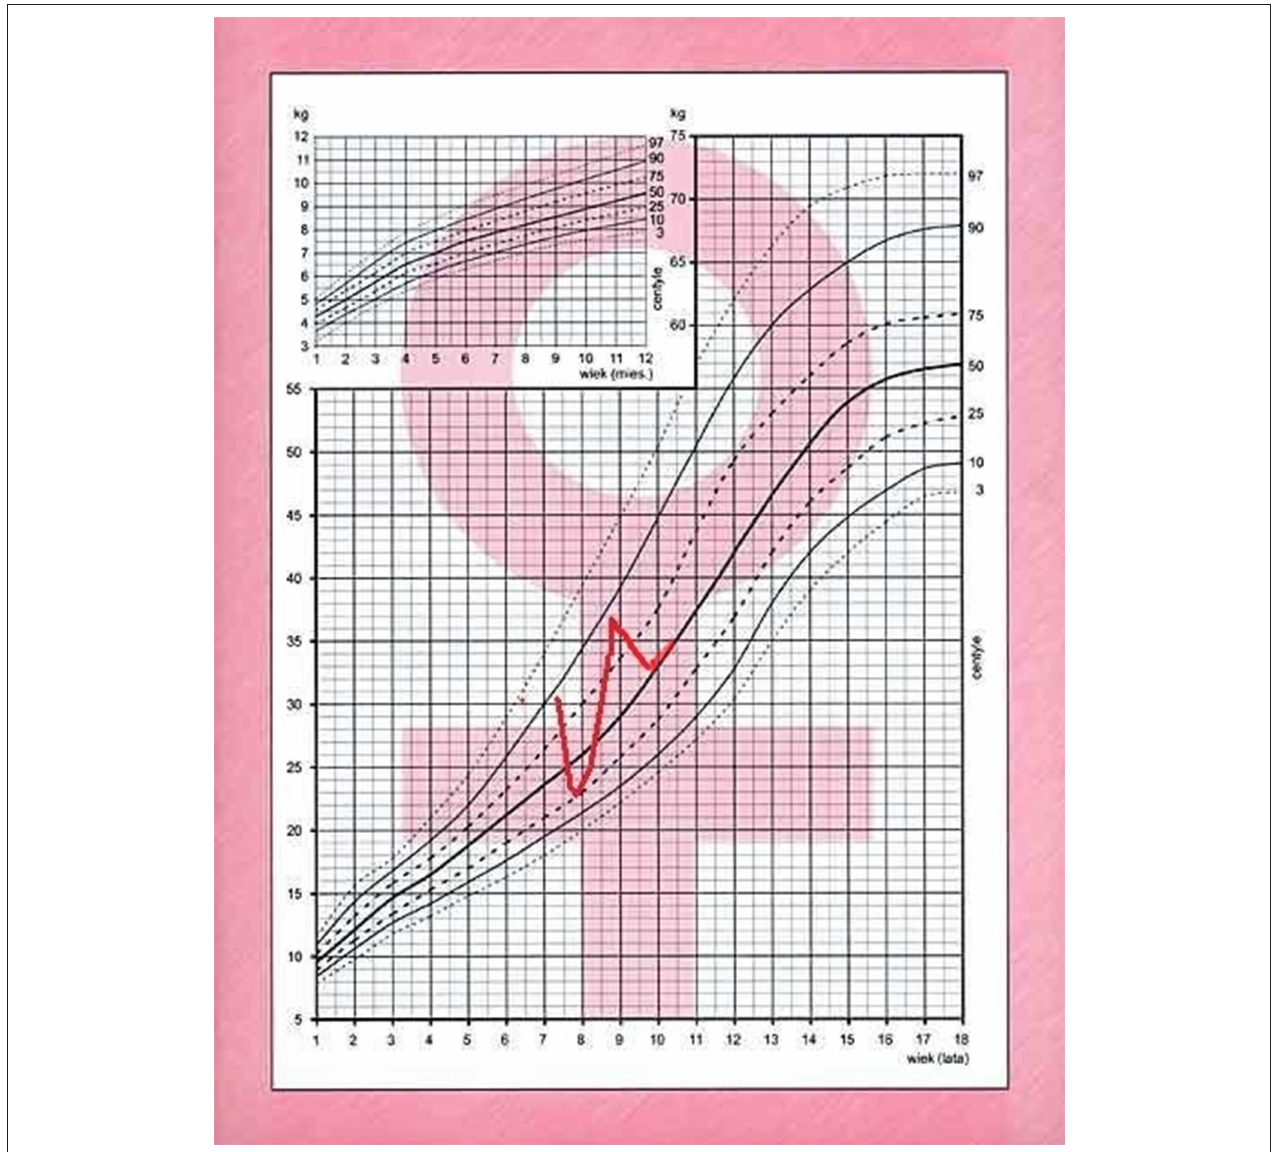
FIGURE 2 | Body mass chart of the patient with cyclic Cushing’s